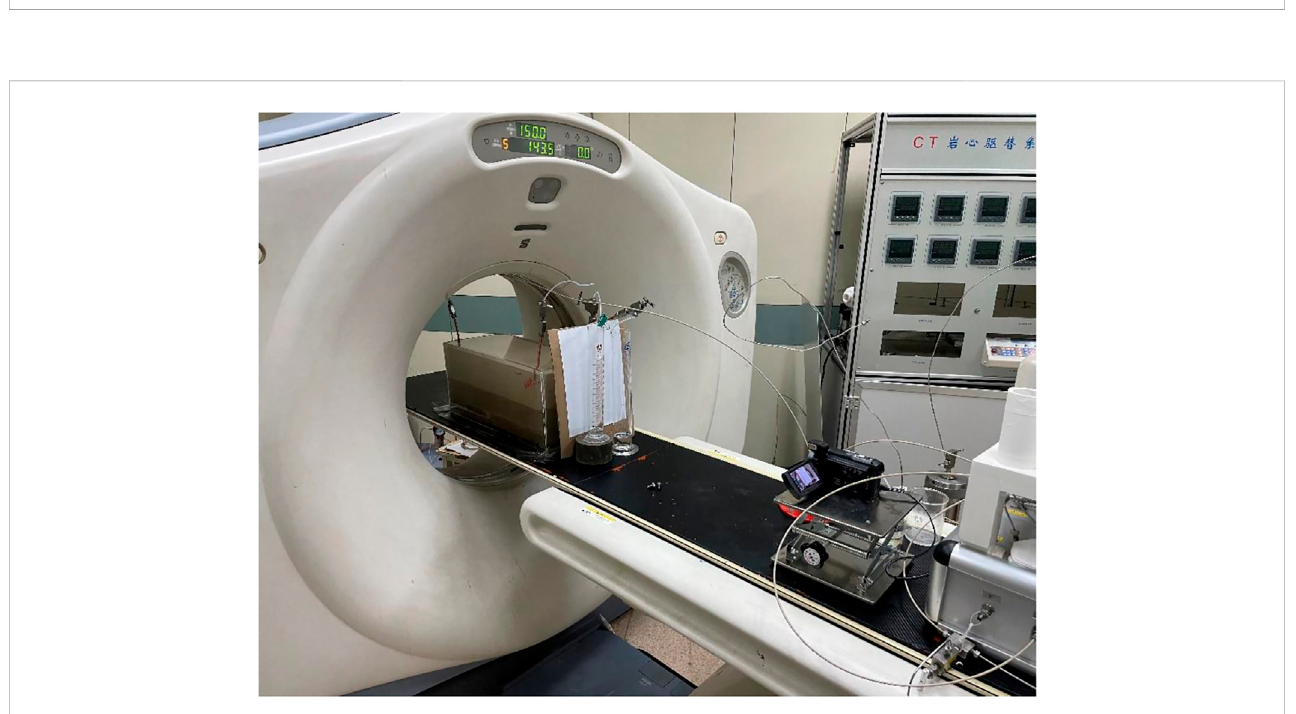
FIGURE 2 Physical modelling platform for mechanism study on development adjustment strategy of heterogeneous thick